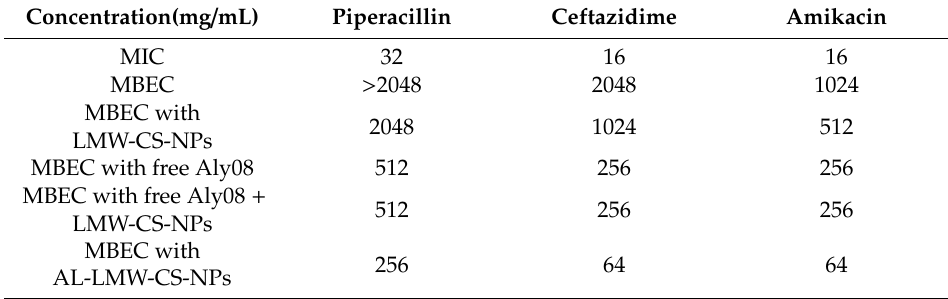
Table 1. Antibiotic sensitivity of P. aeruginosa PAO1 as a planktonic population (minimum inhibitory concentration, MIC) and as a biofilm population (minimum biofilm eradication concentration, MBEC). Concentration(mg /